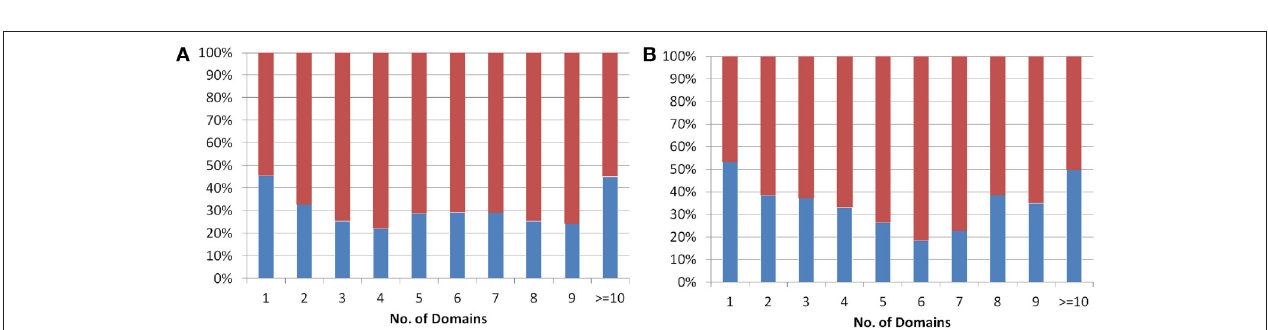
FIGURE 2 | The plot shows the percentage of proteins having one or more than one domain in the old prokaryotic proteins (red) and in new proteins (blue) in Arabidopsis (A) and Oryza sativa (B).